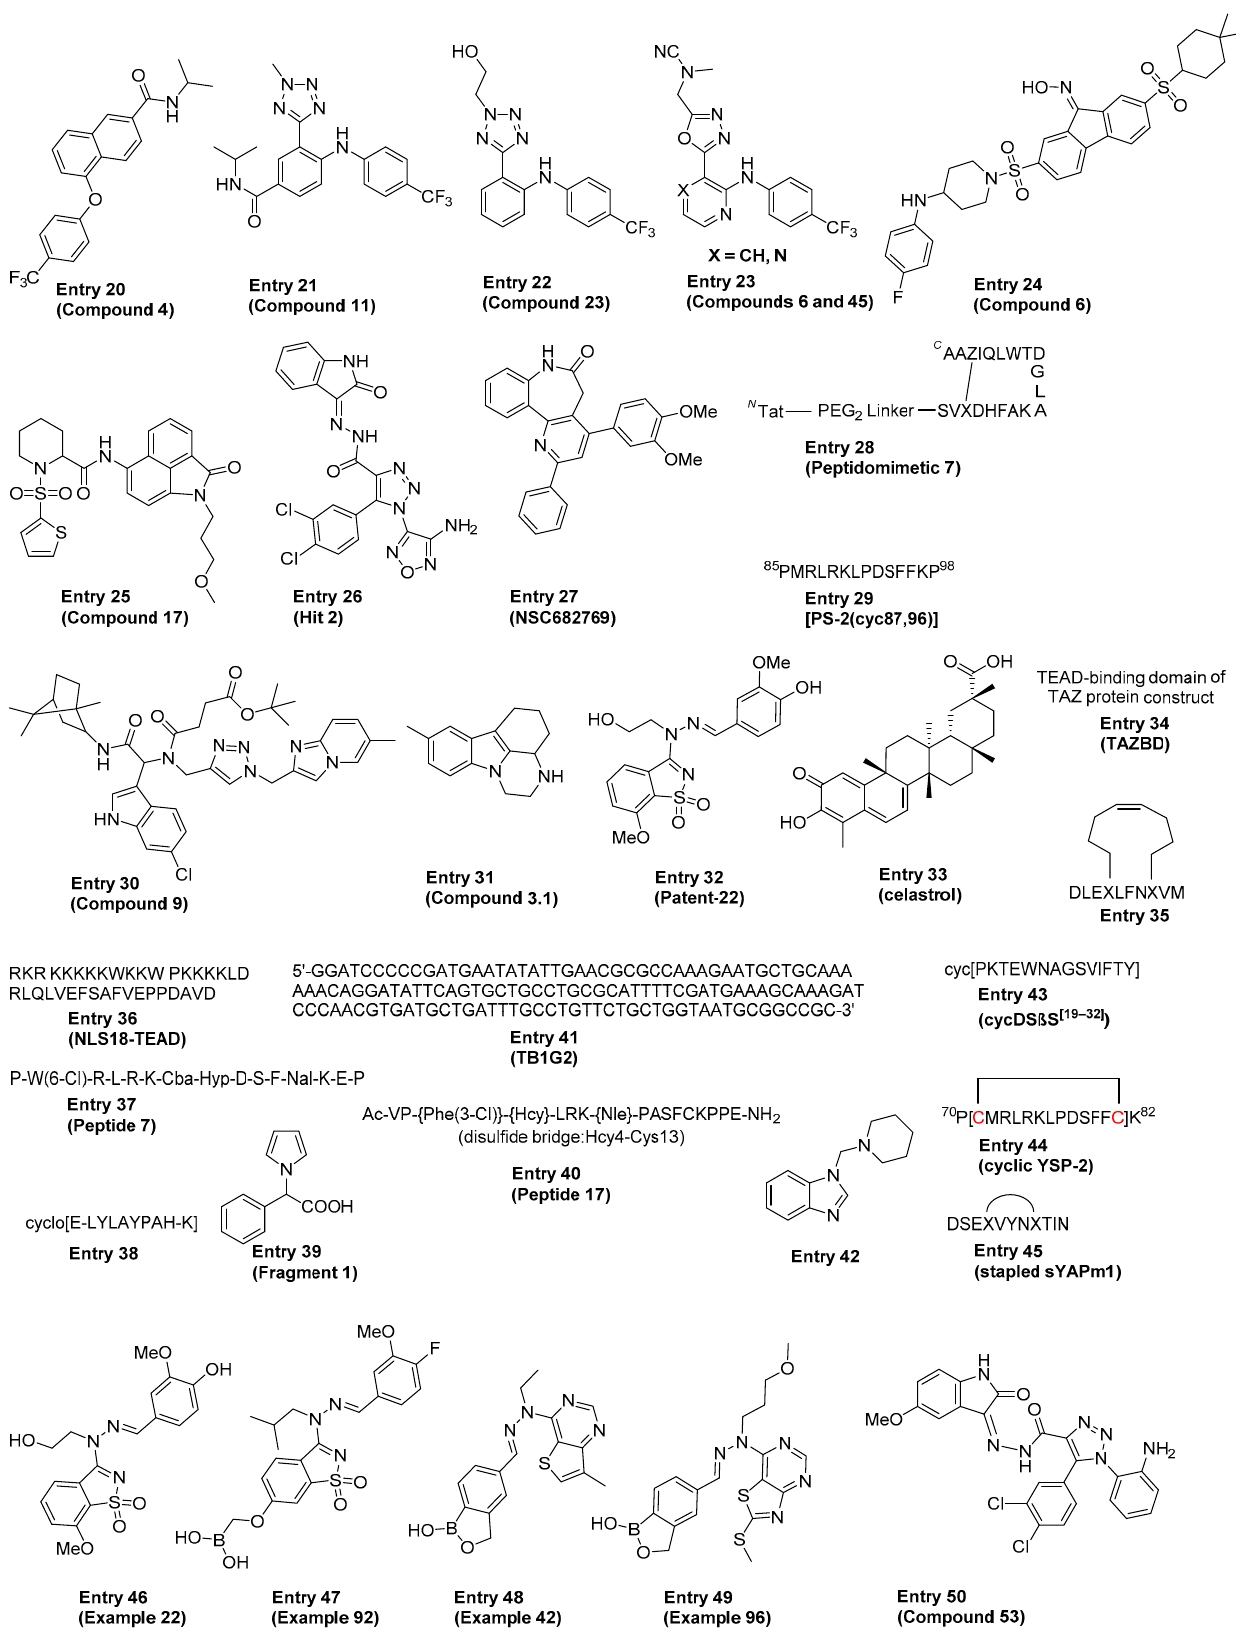
Figure 3. Structures of representative compounds with claims to disrupt the YAP1–TEAD interaction .